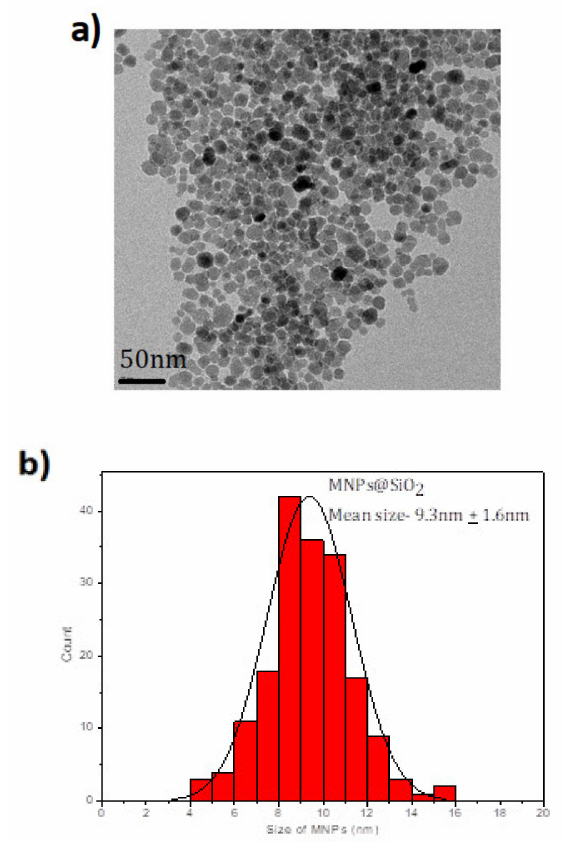
Figure 1. ( a ) The Fe 3 O 4 @SiO 2 modified magnetic nanoparticles (MNPs) under TEM at 120 kV. They were measured in a copper grid. ( b ) The average size of Fe 3 O 4 @SiO 2 MNPs is 9.3 ± 1.6